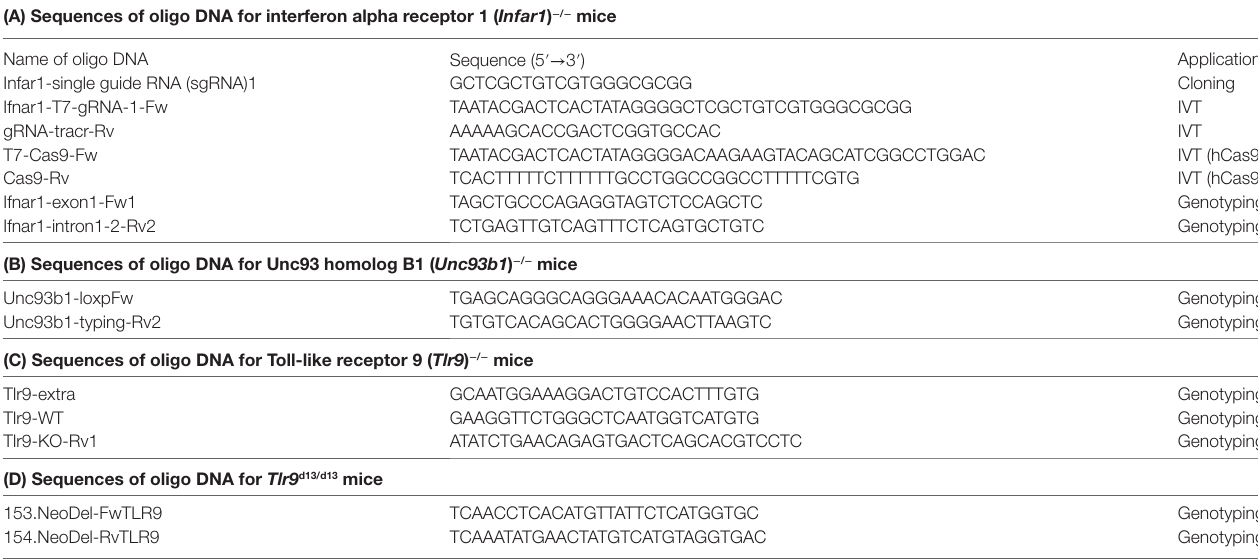
TaBle 1 | Sequences of oligo DNA for generating and genotyping of mutant mice. (a) sequences of oligo Dna for interferon alpha receptor 1 ( Infar1 ) − / −